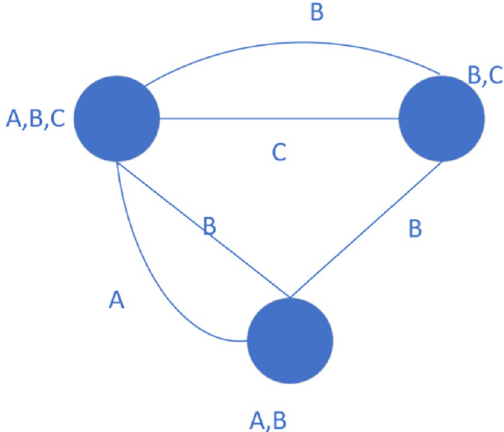
Fig. 1 A graphic representation of the graph-theoretic